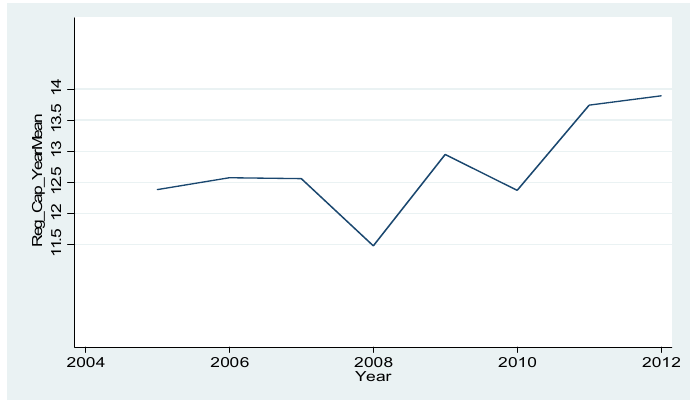
Figure 1. Annual average of capital adequacy ratios of all banks.